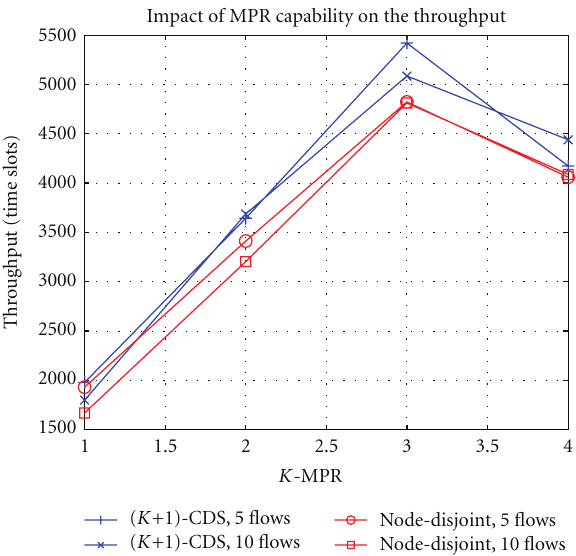
Figure 10: The 3-MPR can achieve the highest